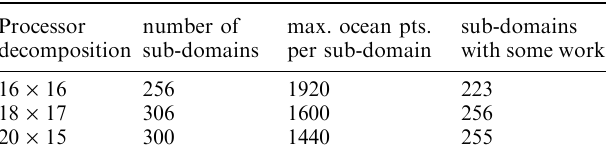
Table 1. 256 processors can be used more e(cid:129)ciently by sub- dividing the model into greater than 256 sub-domains and ignoring those domains with no associated